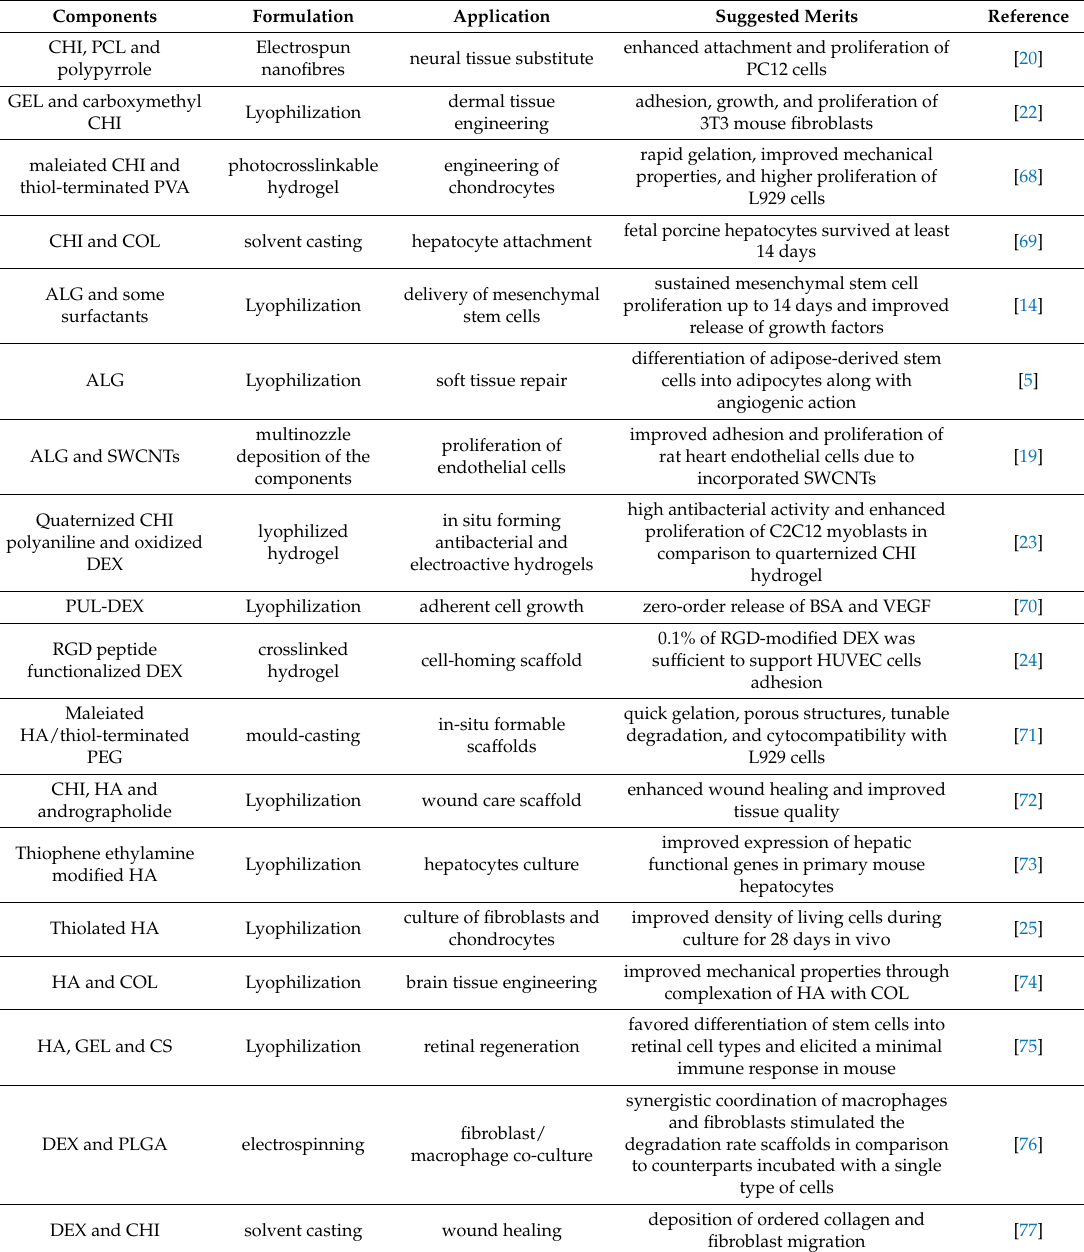
Table 2. Polysaccharide based tissue